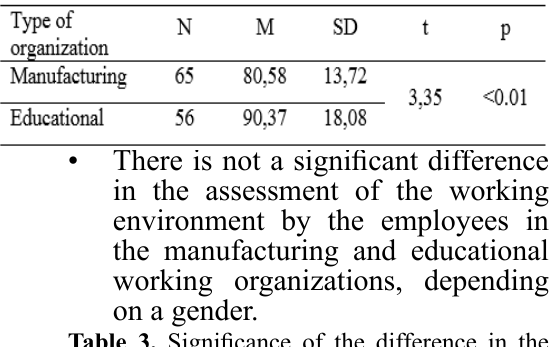
Table 3. Significance of the difference in the assessment of the working environment by the employ -